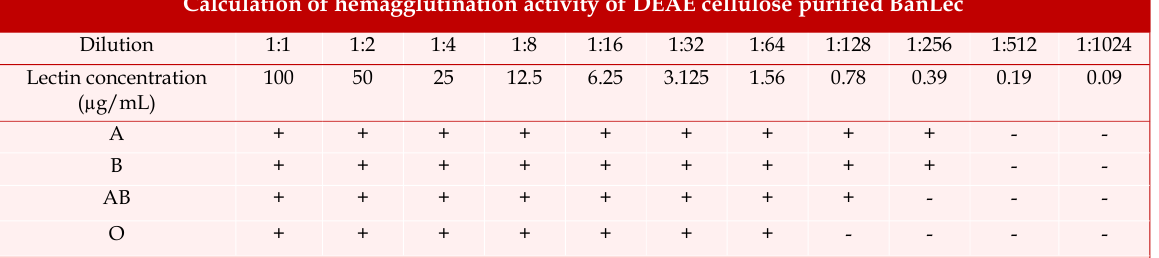
Calculation of hemagglutination activity of DEAE cellulose purified BanLec Dilution Lectin concentration (µg/mL)